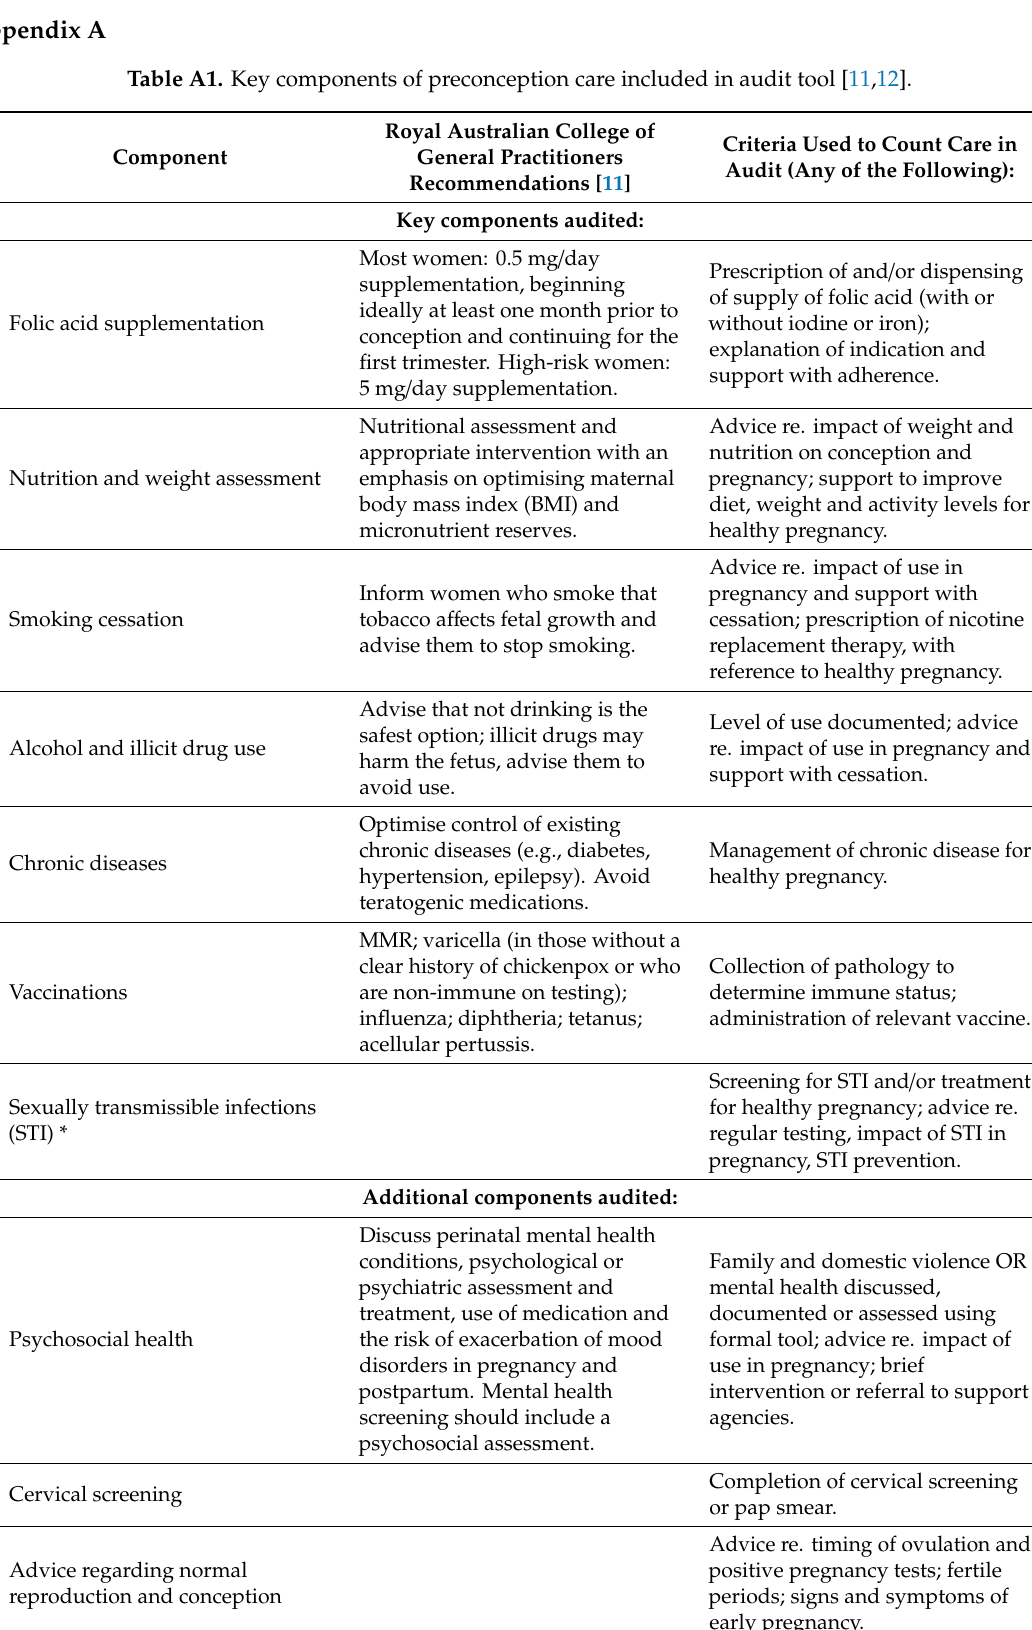
Table A1. Key components of preconception care included in audit tool